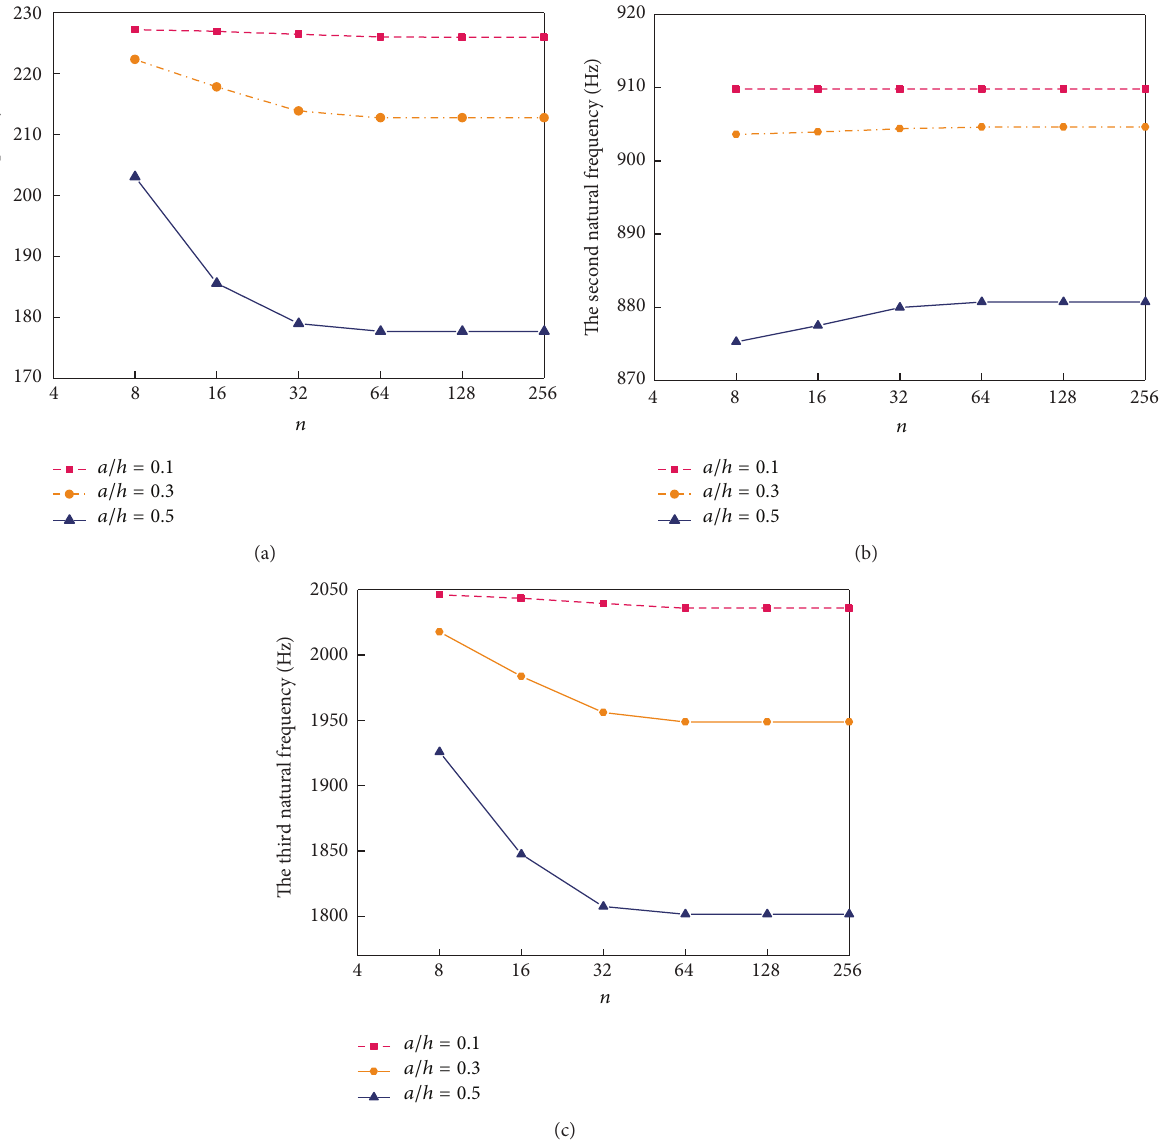
Figure 2: The first three natural frequencies of a hinged-hinged isotropic homogenous beam containing a single open edge crack: (a) the fundamental frequency, (b) the second frequency, and (c) the third frequency.